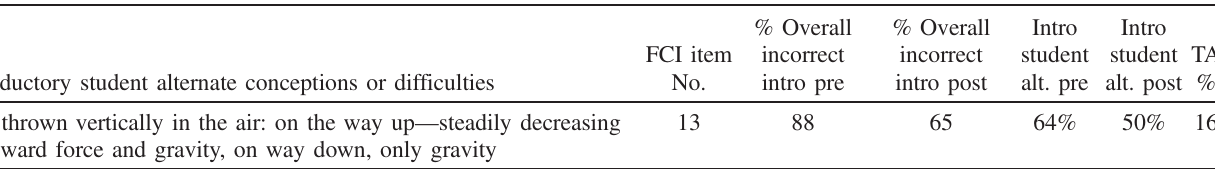
TABLE IV. An example (related to impetus view of motion) in which TAs severely underestimate the percentage of introductory students who select a particular incorrect answer choice. Introductory students ’ alternate conception related to an impetus view of motion, percentage of introductory students who answer the question incorrectly in the pretest and in the post-test, percentage of introductory students who hold this alternate conception in the pretest (Intro student alt. pre) and in the post-test (Intro student alt. post) and percentage of TAs (TA%) who identify it as the most common incorrect answer choice. A brief description of the question is also provided.